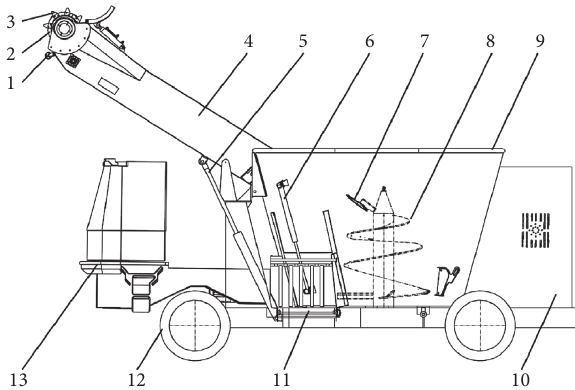
Figure 1: Structure of self-propelled TMR mixer: 1, land wheel; 2, roller; 3, cutter; 4, conveyor; 5, lifting hydraulic cylinder; 6, dis- charging hydraulic cylinder; 7, moving blade; 8, auger; 9, bin; 10, diesel engine unit; 11, discharging device; 12, road wheels; 13,